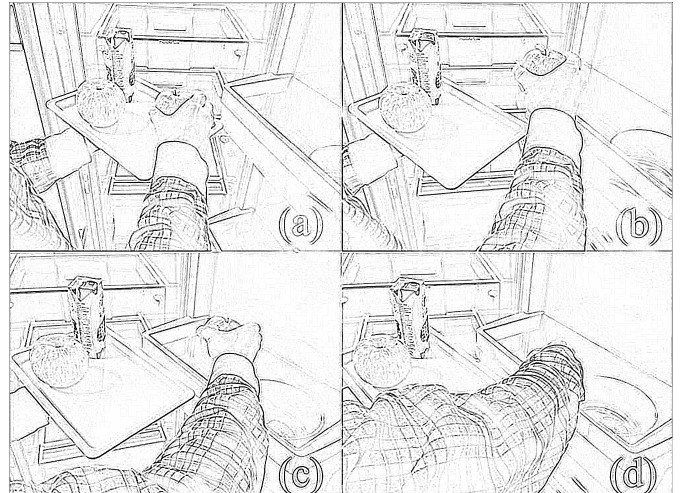
Figure 1. Schematic description of the steps to perform the bimanual complementary task. The left hand, assumed healthy, plays the supportive role and holds the plate. The right hand, assumed impaired, plays the dominant role and performs the task in four steps: ( a ) reaches for the object and holds it; ( b ) takes the object off the plate; ( c ) moves the object towards the target position; ( d ) places the object at the target